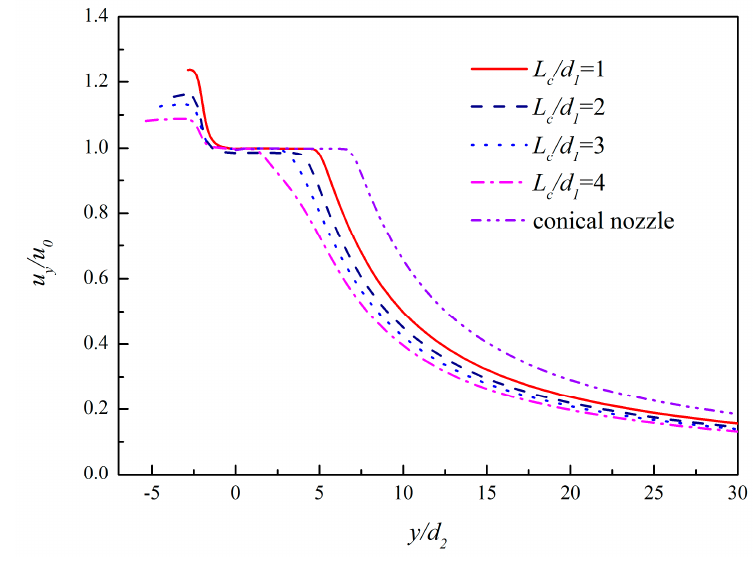
Figure 9. The axis velocity attenuation curves of different cavity length.